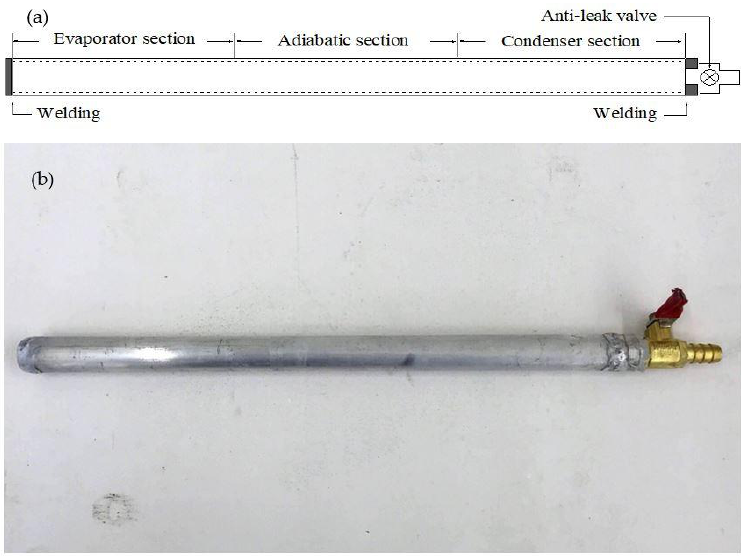
Figure 4. Gravity heat pipe: ( a ) Schematic drawing; and ( b ) photograph.